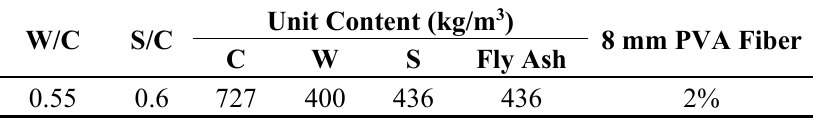
Table 1. High-performance fiber-reinforced cementitious composite (HPFRCC) mixture design.